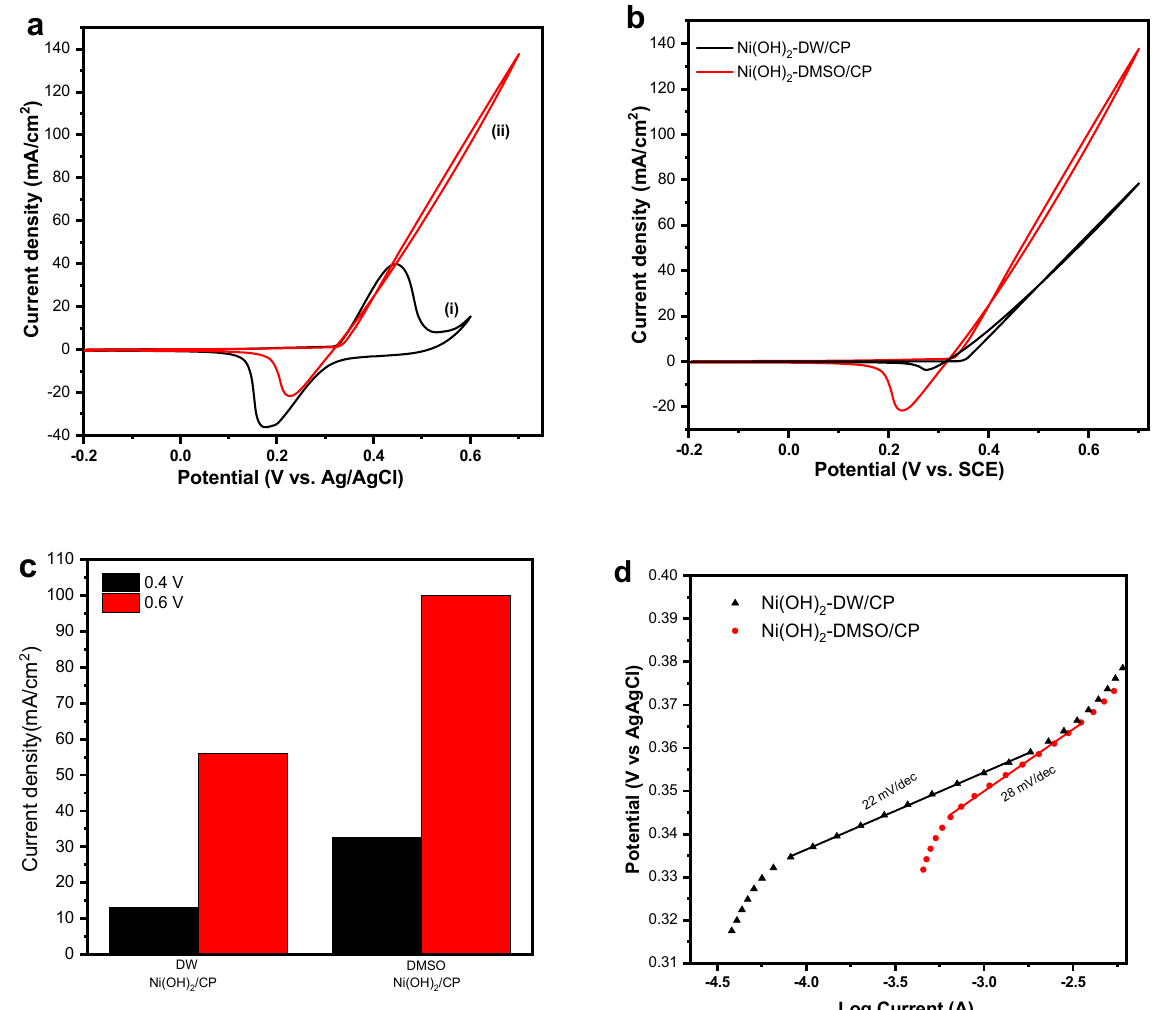
Figure 5. ( a ) Cyclic voltammetric analysis at 50 mV/s for the Ni(OH) 2 -DMSO/CP electrode in the absence (i) and in the presence of 0.33 M urea in 1.0 M KOH (ii), ( b ) CVs for Ni(OH) 2 /CP catalysts deposited from deionized water (DW), and DMSO in 0.33 M urea/KOH, ( c ) The current density of the Ni(OH) 2 /CP electrodes prepared with different solvents at the potential of 0.4 V and 0.6 V vs. Ag/AgCl. ( d ) Tafel slope of the polarization curves in (Figure 5b).